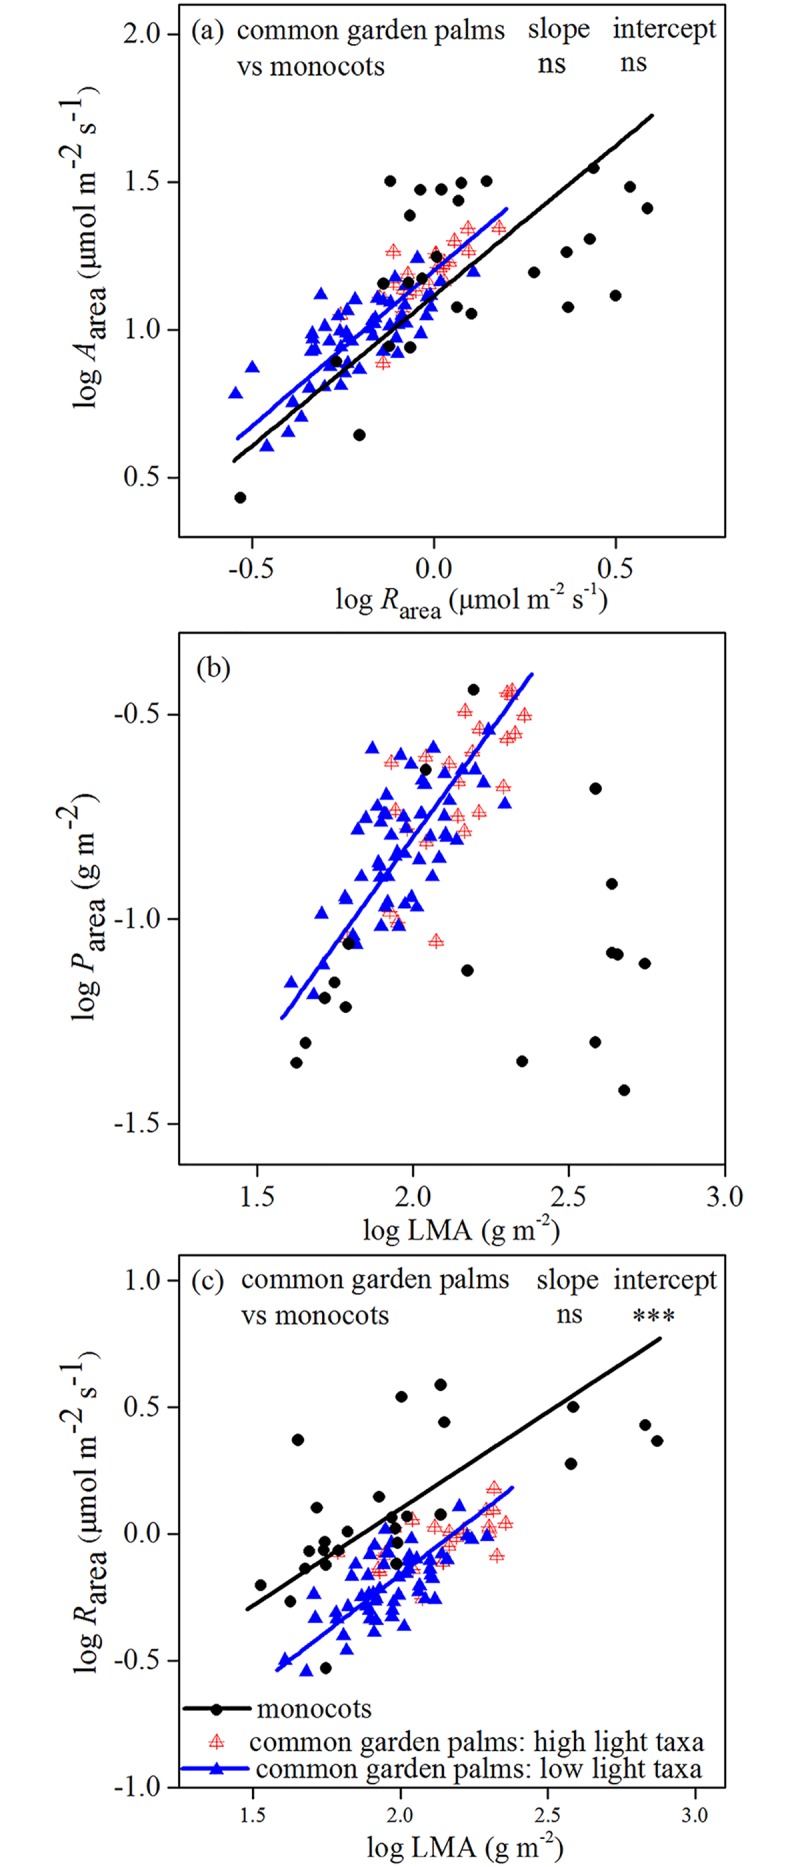
Trait relationships across common garden palms and other monocots.(a) Area-based maximum photosynthetic rate (A
area) versus dark respiration rate (R
area), (b) area-based phosphorus concentration (P
area) versus leaf mass per area (LMA), (c) and R
area versus LMA. Standardized major axis (SMA) regression lines are only shown for significant trends. The differences in SMA regression slope and intercept between common garden palms and other monocots are indicated. ns, P > 0.05, *** P < 0.001.